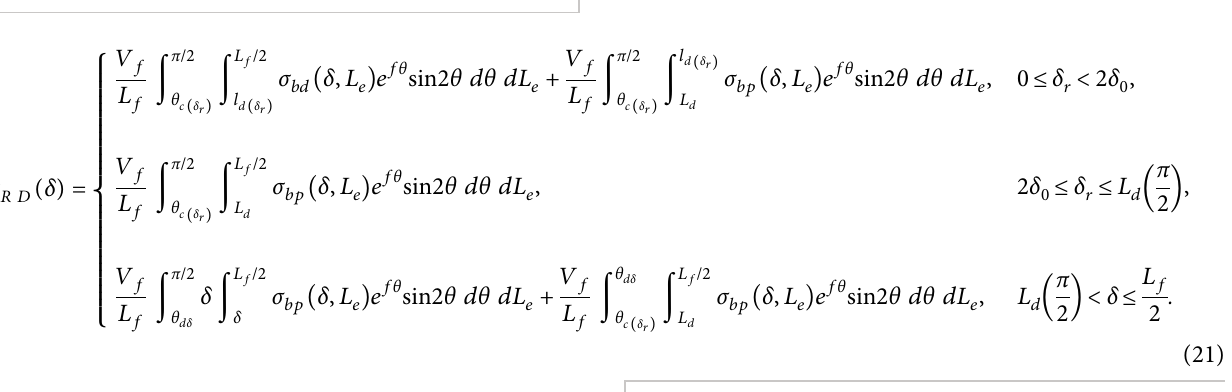
Figure 8: The 3D slipping ruptured